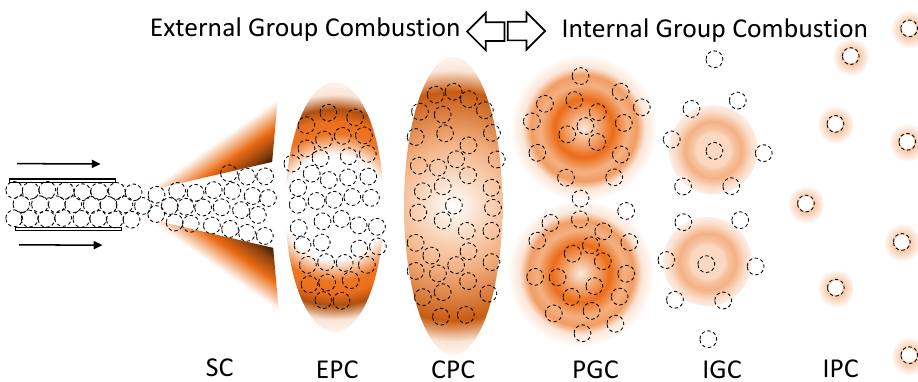
Figure 11. Schematic of group combustion in nanothermite jet suspension considering convec- tive